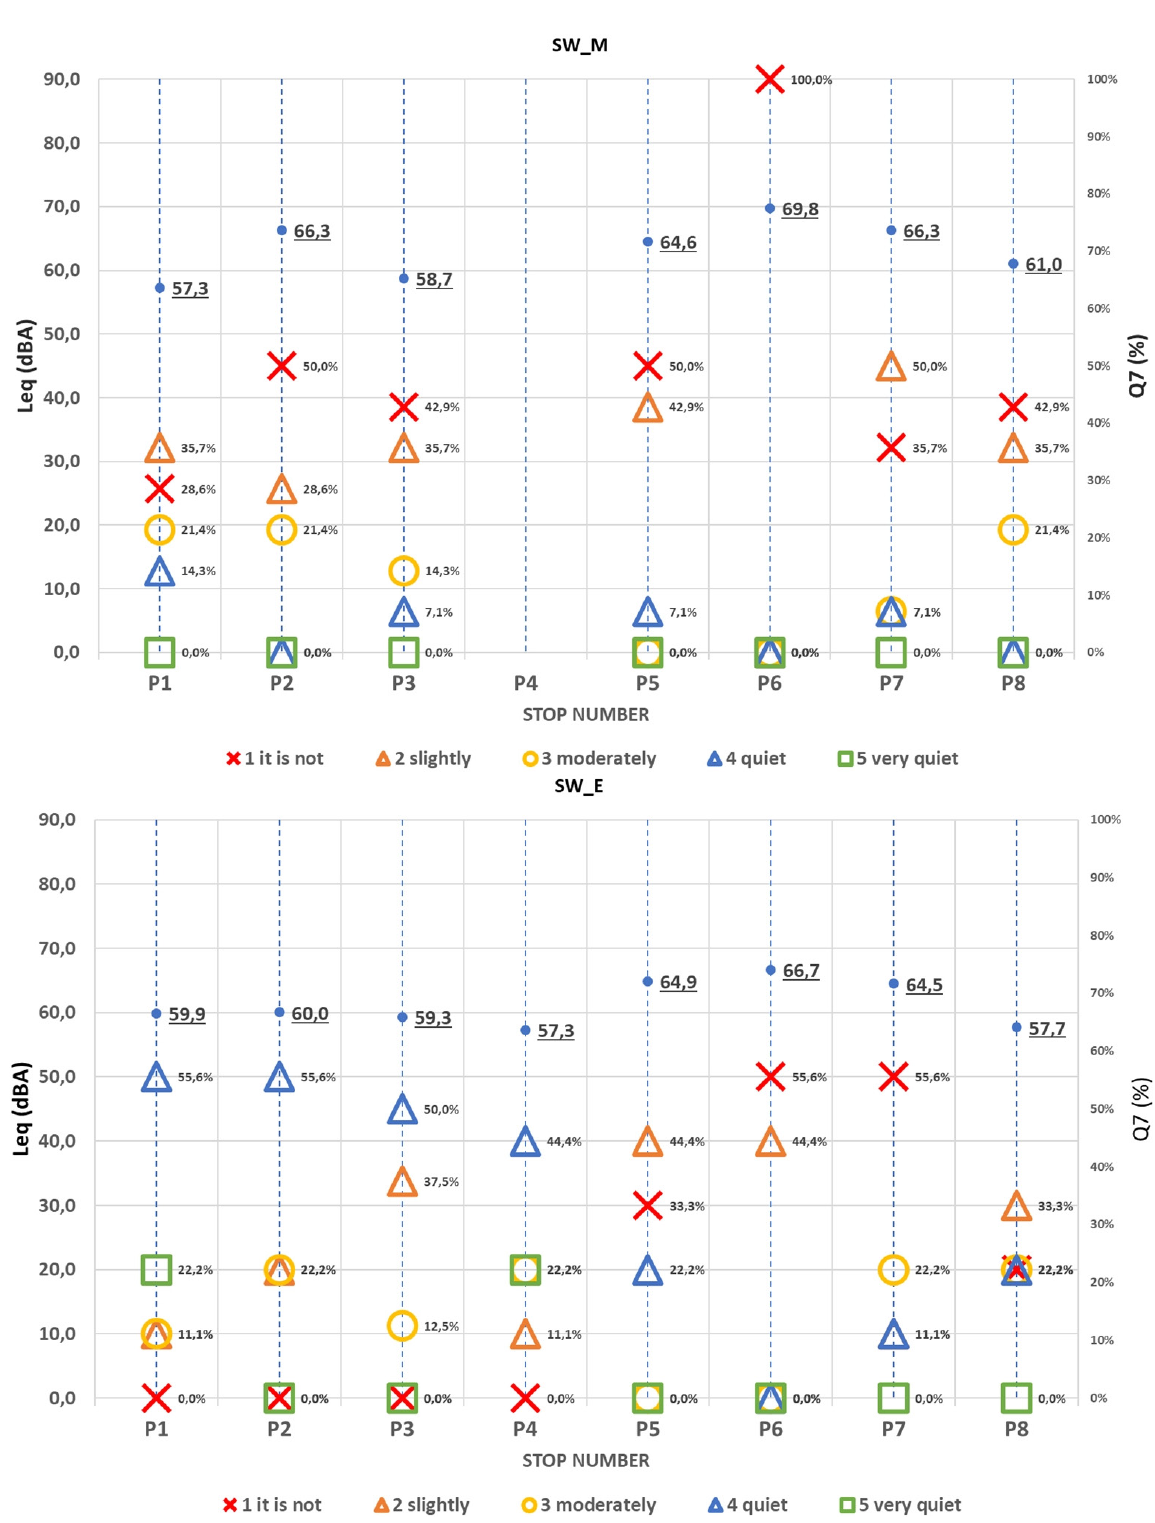
Figure 22: Percentage distribution of the five ordinal-category scale answers to question Q7 (overall quietness, right axis) and equivalent noise level descriptor (left axis) at every stop in path during the morning (up) and evening (bottom)